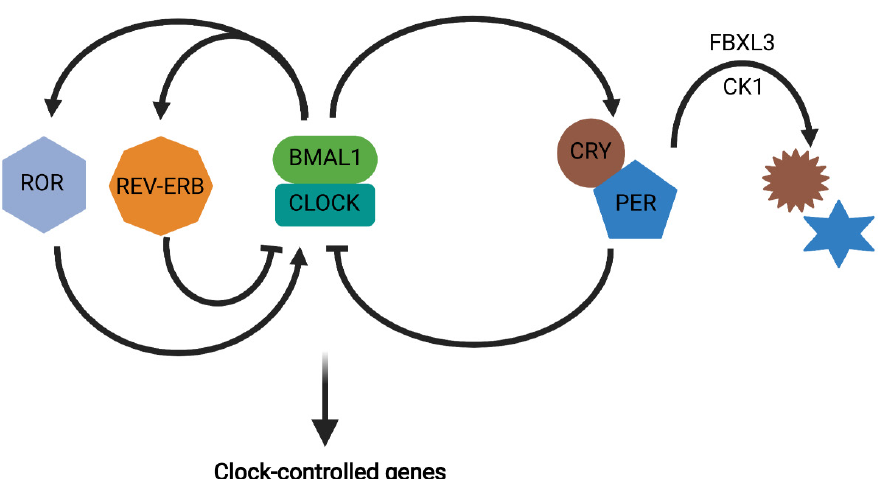
Figure 1. The core molecular clock consists of a positive arm in which BMAL1 and CLOCK heterodimerize to induce expression of the negative arm consisting of PER and CRY, which then feedback to inhibit BMAL1 and CLOCK. Additionally, BMAL1/CLOCK activate REV-ERB α / β and ROR α / γ which have opposing roles in regulation of ARNTL (which encodes BMAL1), whereby REV-ERB α / β stimulates and ROR α / γ inhibits ARNTL expression. Protein degradation mediated by CK1 δ / ε and FBXL3, generates the 24-h circadian period. Finally, transcriptional regulation of clock-controlled genes by the core clock establishes a circadian rhythm in a wide range of cellular functions. Figure created with BioRender.com.